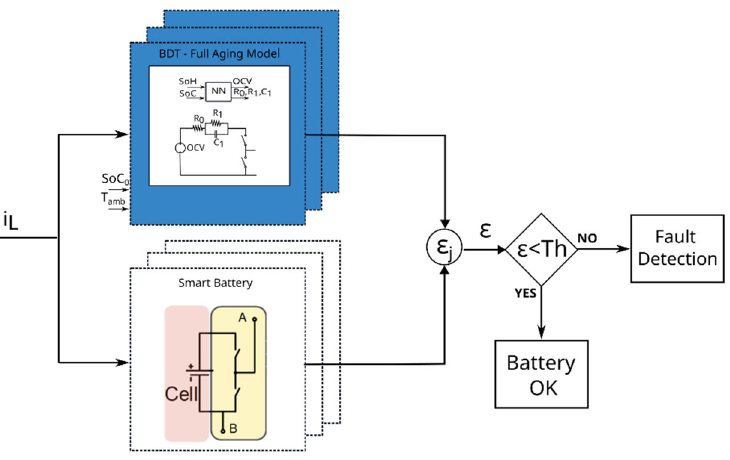
Figure 12. BDT used in predictive